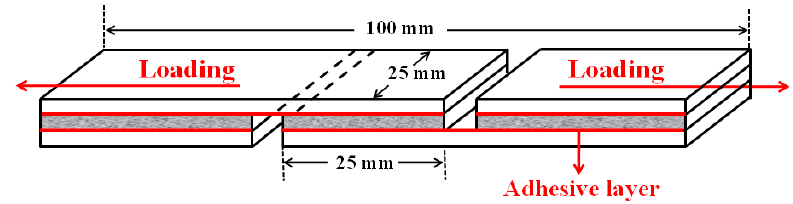
Scheme 2. Schematic diagram of the specimen used for the shear strength measurement.